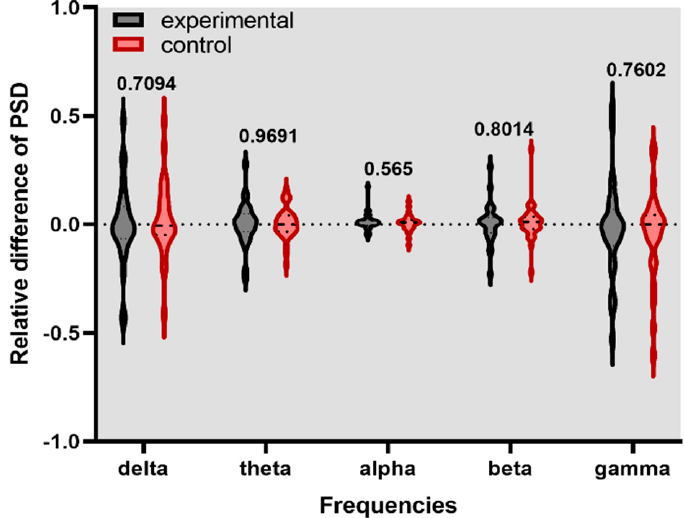
Figure 6. Relative difference of PSD for F2 channel during the N-back task.